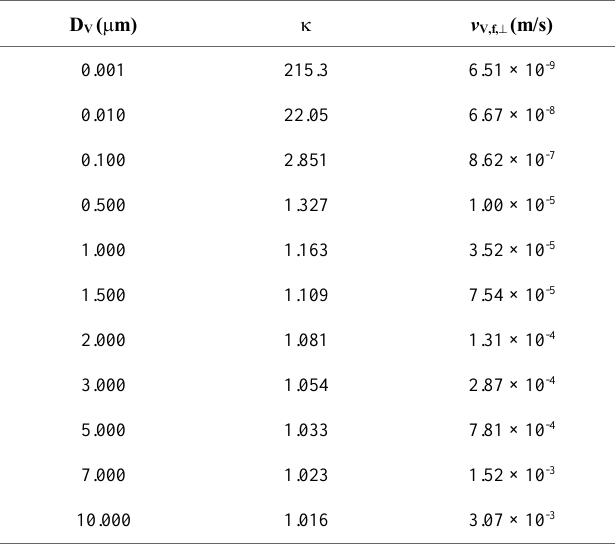
Table 1. Cunningham slip correction factor and terminal